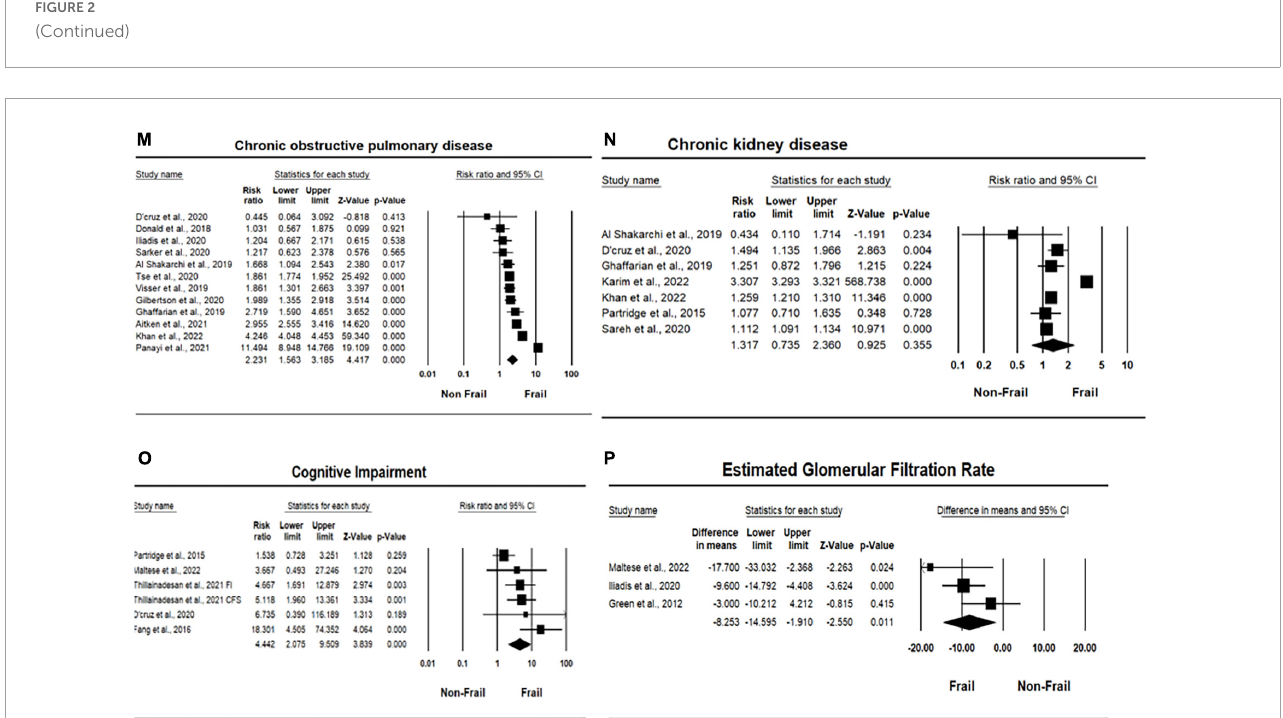
FIGURE2 Forest plots of association between frailty and health outcomes for patients who underwent vascular surgery. (A) In-hospital mortality. (B) Post-discharge mortality. (C) Length of hospital stay. (D) Rehospitalisation. (E) Discharge location. (F) Post-operative myocardial infarction. (G) Renal failure. (H) Stroke. (I) Hypertension. (J) Cardiovascular disease (CVD). (K) Peripheral vascular disease (PVD). (L) Diabetes. (M) Chronic obstructive pulmonary disease (COPD). (N) Chronic kidney disease (CKD). (O) Cognitive impairment. (P) Estimated glomerular filtration rate (eGFR).